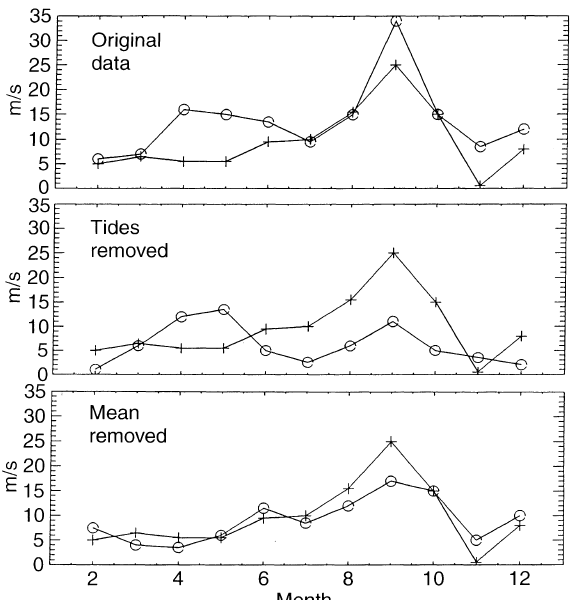
Fig. 3. Illustration of how changes in the mean zonal flow alias into determinations of the diurnal tide using data from a satellite which is precessing slowly in local time. Top : hourly eastward winds over Saska- toon during 1979. Bottom : satellite- based ( circles ) determinations of the diurnal component of the eastward wind corresponding to an orbital inclination of 70 (cid:14) , compared to the true or ground-based results ( crosses ). Note how the evolution of the mean circulation around the equinoxes ( top ) is seen from the satellite perspective as a local-time variation, manifested in the large and erroneous determinations of the diurnal tide ( circles, bottom )